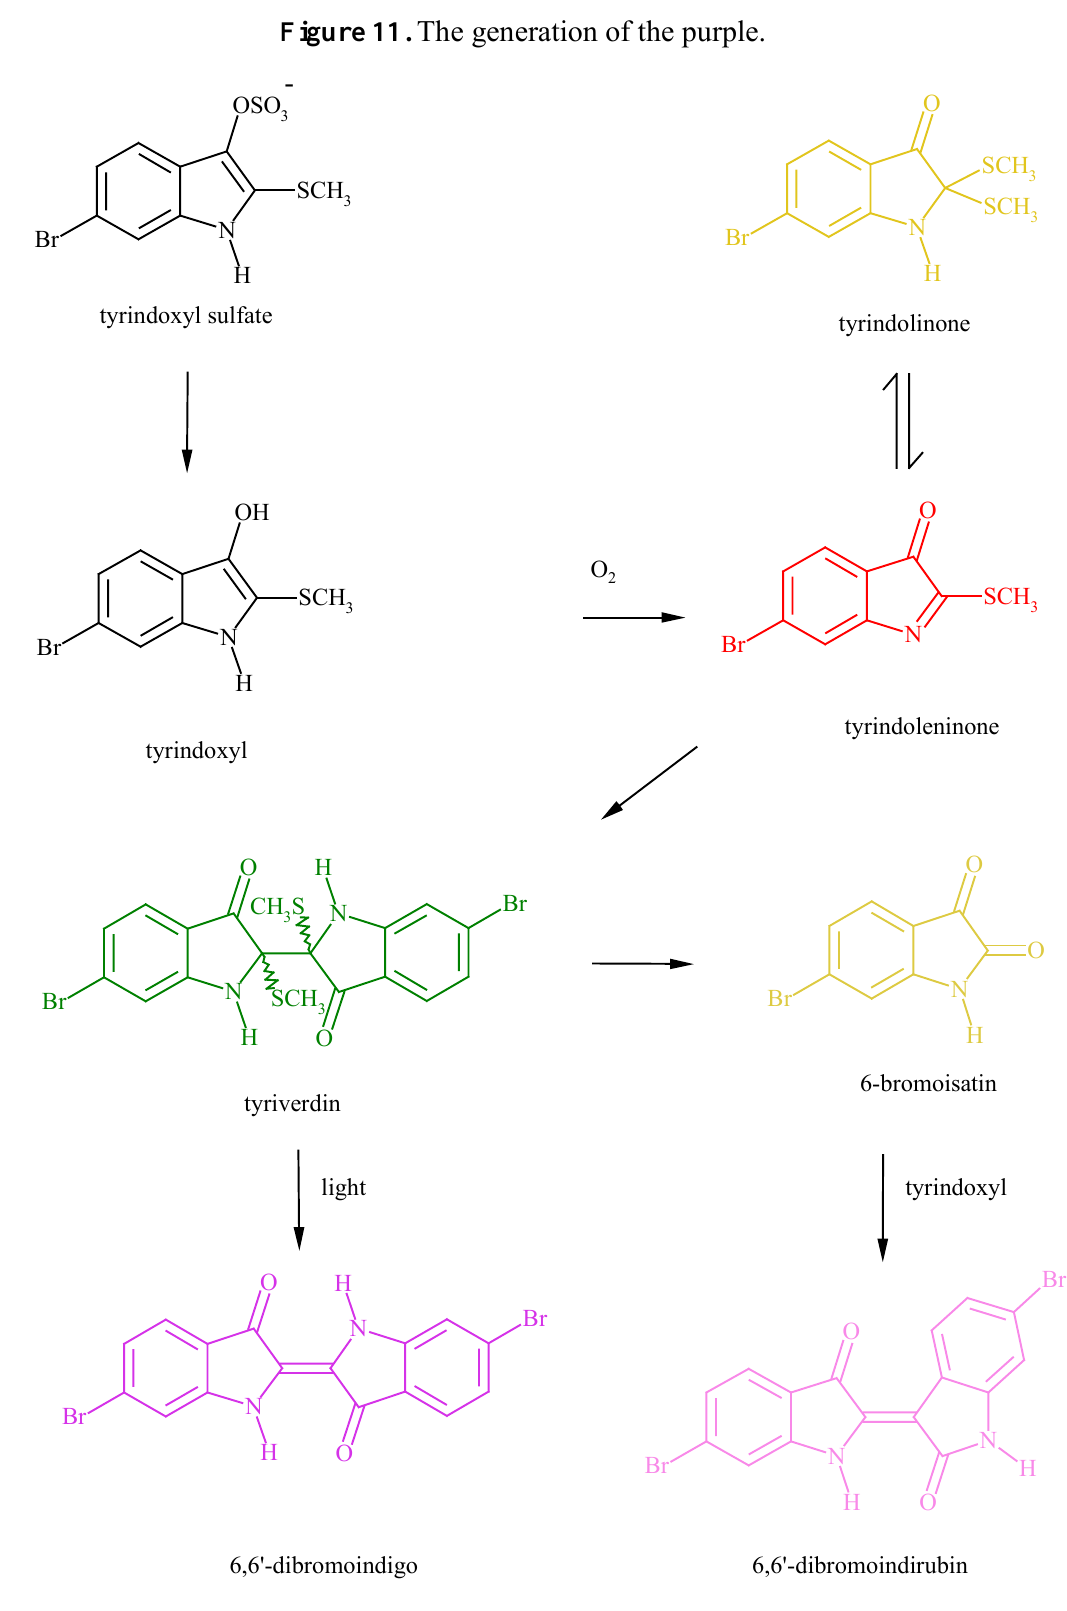
Figure 11. The generation of the